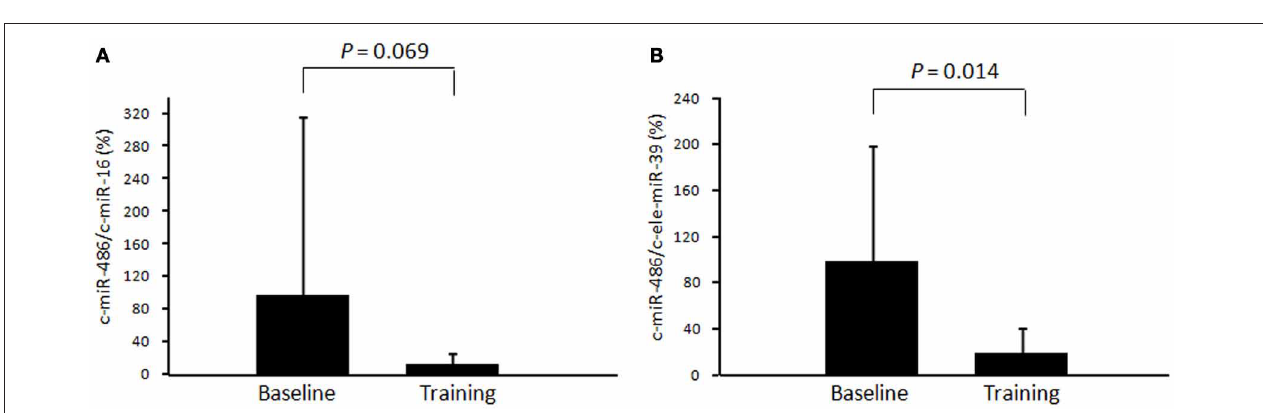
to that for miR-16 (A) and cel-miR-39 (B) was calculated for each serum sample. Values represent the mean ± standard deviation obtained from 10